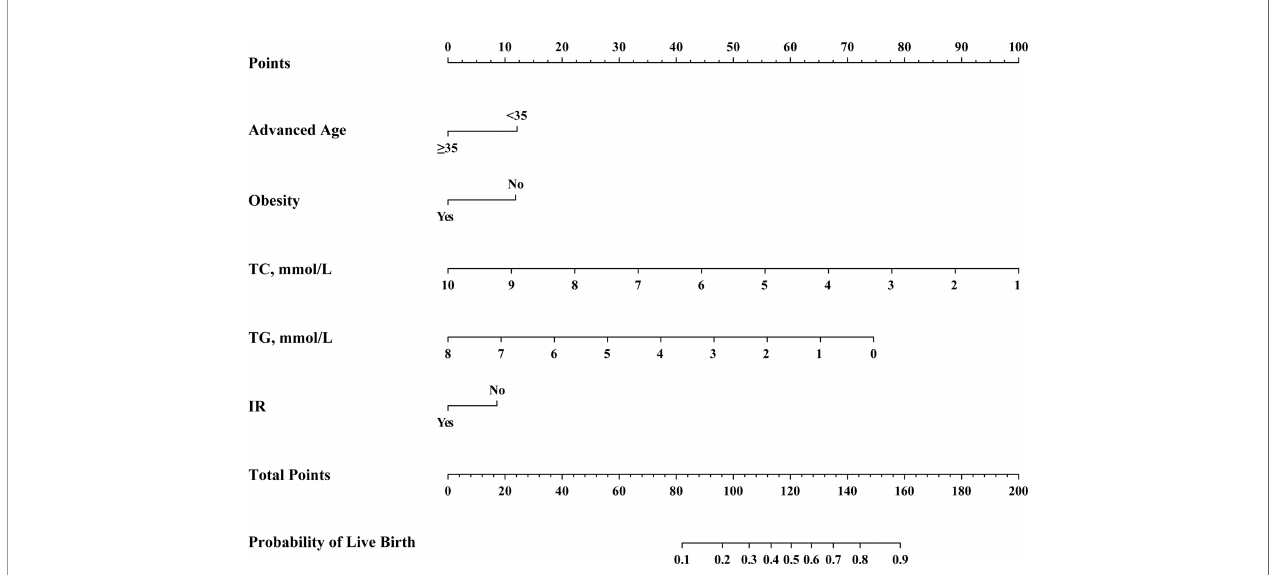
FIGURE 2 | Nomogram for the pre-transfer prediction of live birth odds in PCOS patients undergoing F-ET. F-ET, frozen-thawed embryo transfer; FSH, follicle- stimulating hormone; IR, insulin resistance; TC, total cholesterol; TG,